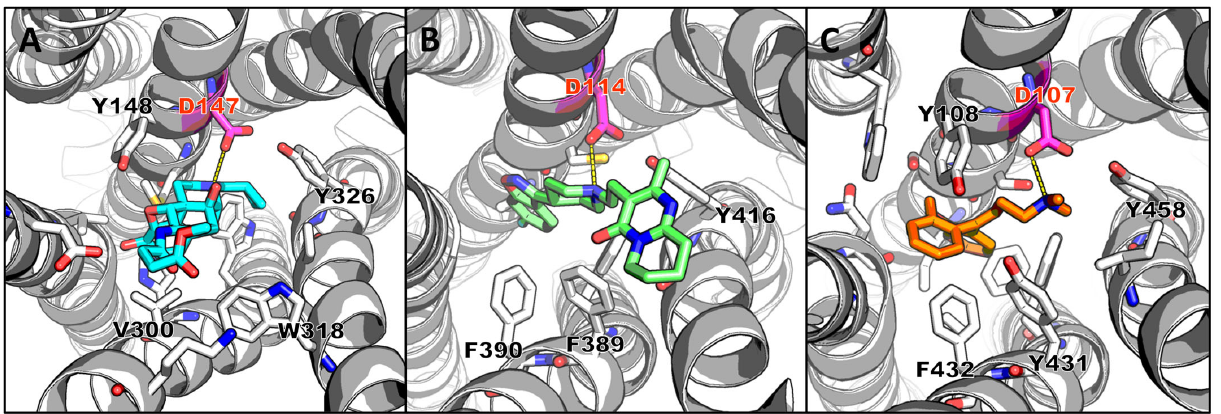
Figure 2. Illustration of the key interactions between amino acid residues in the binding site and the crystallographic ligand. ( A ) μ‐ opioid receptor and a morphinan antagonist (PDB ID: 4DKL) [77], ( B ) dopamine D2 receptor and risperidone (PDB ID: 6CM4) [78], and ( C ) histamine H1 receptor and doxepin (PDB ID: 3RZE) [79].